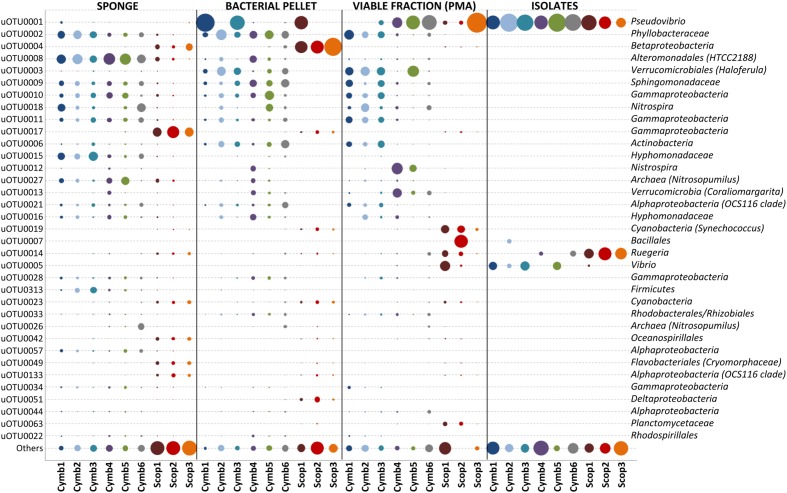
Relative abundances of the 35 overall most abundant uOTUs (normalized for gene copy number). Relative abundances shown in proportion to area of bubbles; uOTU taxonomy shown up to the lowest taxon based on SILVA, RDP and Greengenes classification, with a confidence threshold >60%.